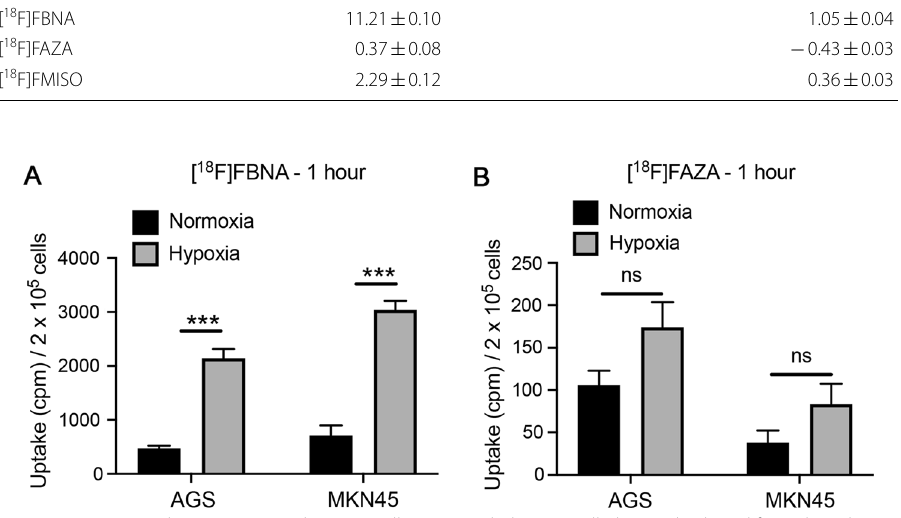
Fig. 6 In vitro uptake assay. AGS and MKN45 cells were seeded in a 6-well plate and cultured for 48 h under normoxic (21% O 2 ) or hypoxic (1% of O 2 ) for 48 h. After this period, 0.37 MBq of ( A ) [ 18 F]FBNA or ( B ) [ 18 F] FAZA was incubated for 1 h. Bars show the mean standard deviation (SD) of the uptake of the radiotracer ± (cpm)/2 10 5 cells of three independent experiments (n 3). Data were analyzed by one unpaired t -test × = (multiple t tests); * p < 0.5, **** p < 0.0001 (Holm-Sidak